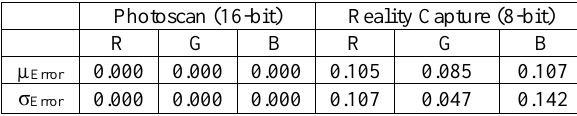
Table 2. 16-bit colour errors (measured in tones) of a colour chart measured before and after processing the images in Agisoft Photoscan (2018) and Capturing Reality Capture (2018) For the 32-bit test, the images were linearly converted down to 16-bits before the RGB values of the patches were sampled; the results can be seen in Table 3. The output from Reality Capture was an 8-bit image, despite the input of the 32-bit data. As a result, the comparison was made between the Reality Capture 8- comparison shown in Table 1. The errors from both Photoscan and Reality Capture are low, and consistent with expected